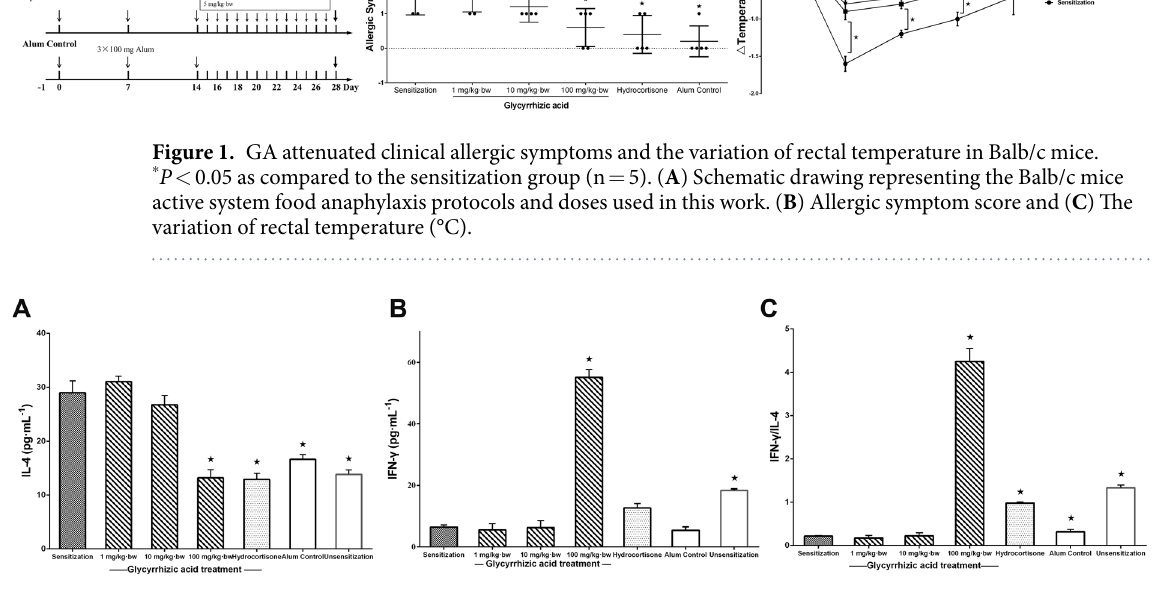
Figure 2. GA worked on T H cells to modulate the T H 1/T H 2 subsets balance. * P < 0.05 as compared to the sensitization group (n = 5). ( A ) Concentration of IL-4 and ( B ) IFN- γ in spleen cells. ( C ) The ratio of IFN- γ and